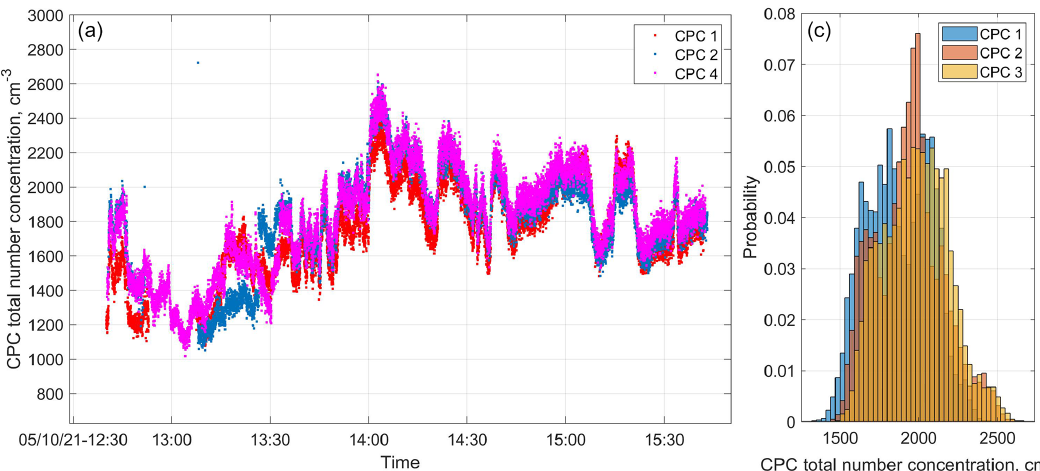
Figure 5. Aerosol total number concentration comparison between three CPCs at the top of a trailer. (a) Time series of the total number concentrations from three CPCs. (b) Histogram of total number concentrations for three CPCs during the comparison period 13:40–15:30LT, 10 May 2021.